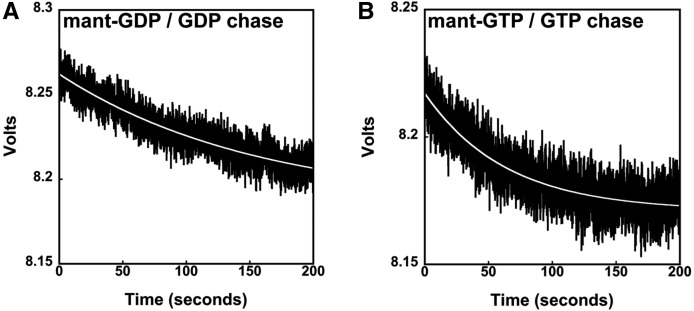
Measurements of the dissociation of mant-nucleotides from RF3. The rate of (A) mant-GDP and (B) mant-GTP dissociation from RF3 was monitored by stopped-flow fluorescence upon the addition of a nonlabeled nucleotide (GDP or GTP) chase. The data were fit to a single phase, and the fit is displayed as a white line. The rates of nucleotide release from RF3 were slow (koff, mantGDP = 0.005 sec−1, koff, mantGTP= 0.01 sec−1).